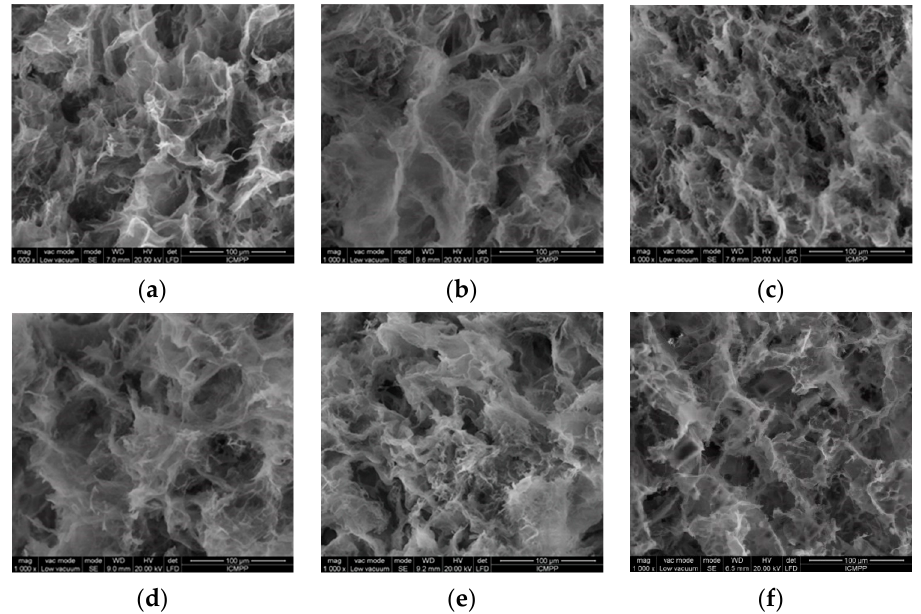
Figure 1. SEM micrographs of 90%PVA/10%HPC hydrogels with different content of BSA (%): ( a ) 0; ( b ) 10; ( c ) 30; ( d , e ) 50; ( f ) 90 (magnitude 1000 × ). The hydrogels were obtained from the solution after applying ( a – d ) 3 or ( e , f ) 8 freezing/thawing cycles. (Adapted with permission from Ref. [40]. Copyright 2022, Elsevier Ltd.).